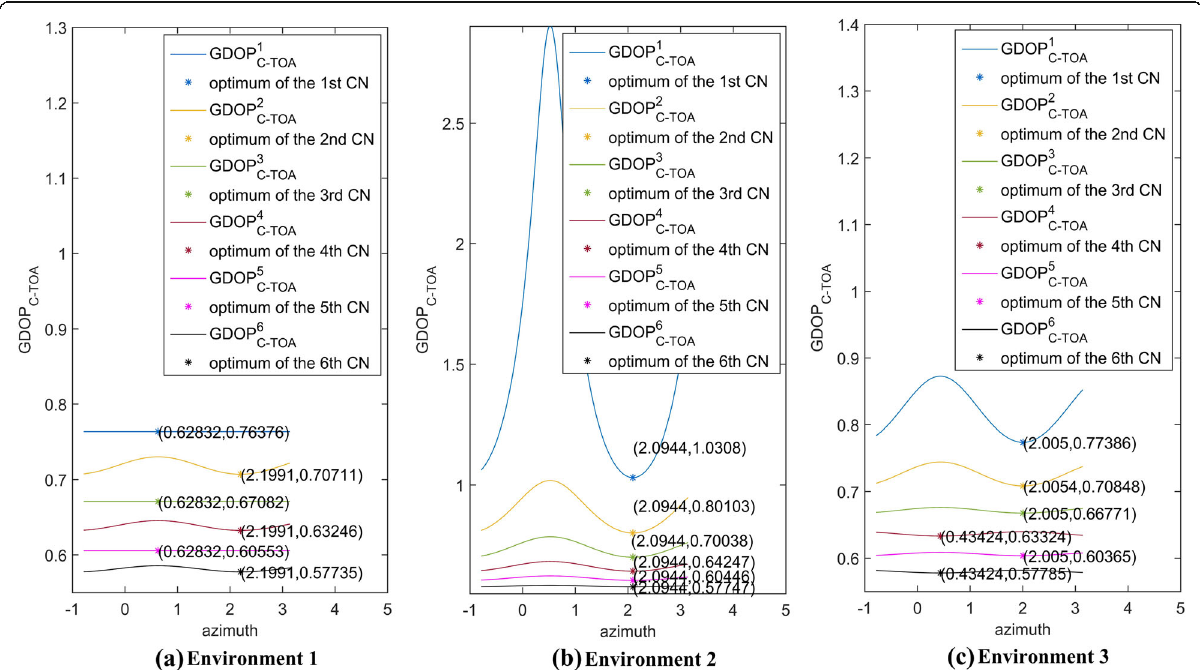
Fig. 4 Performance of partial exhaustive method towards TOA-based system. a Environment 1. b Environment 2. c Environment 3